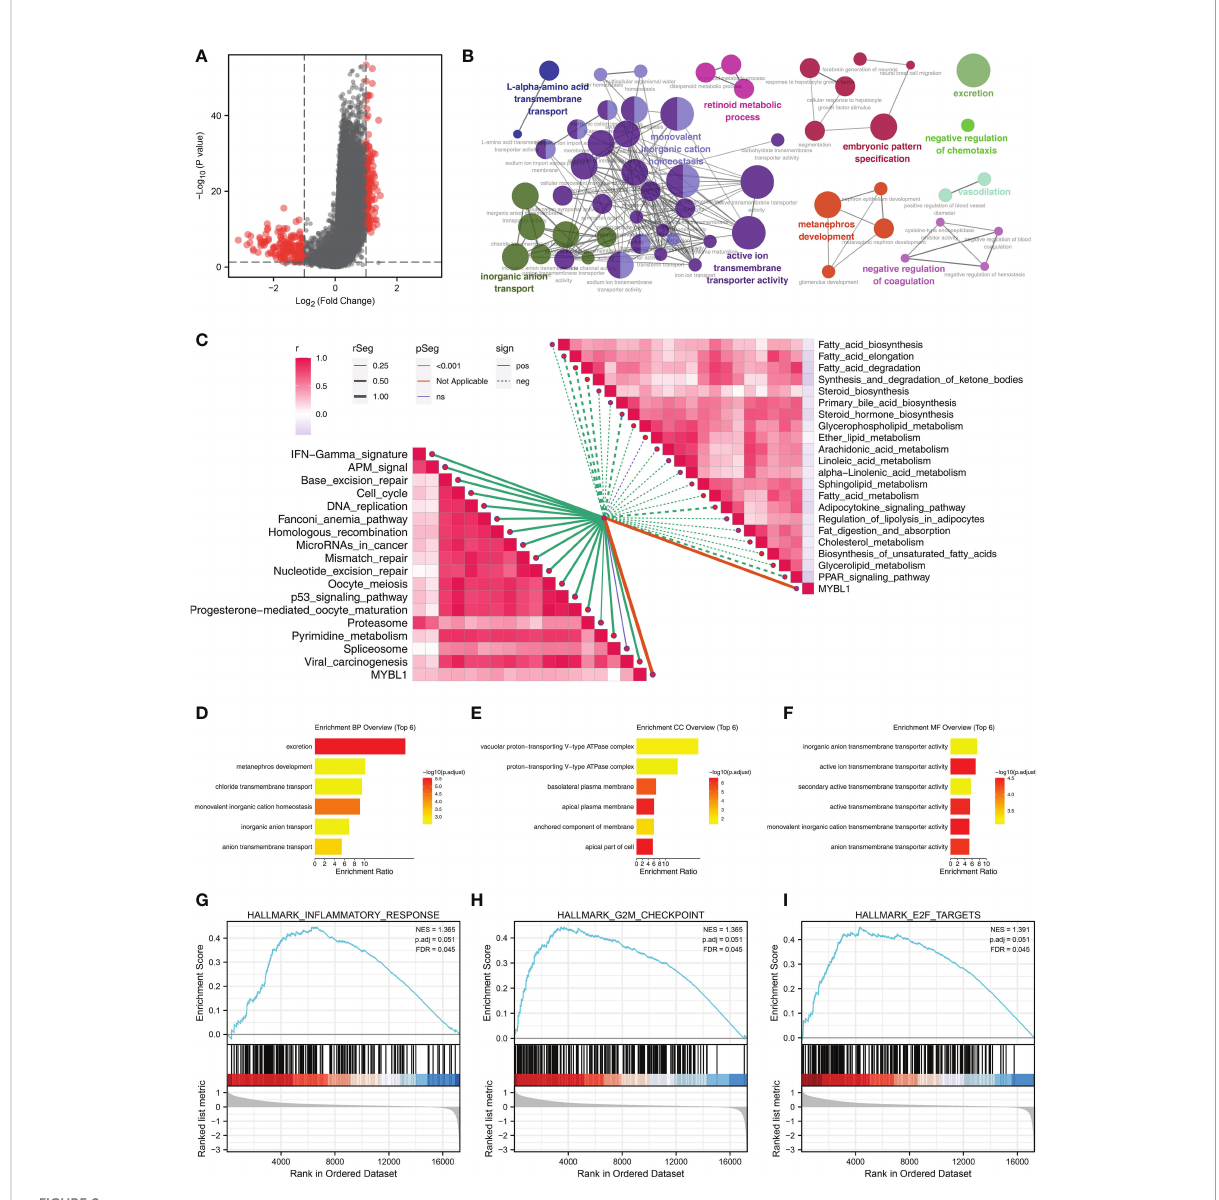
FIGURE 2 The biological role of MYBL1. (A) DEGs between the high and low MYBL1 expression; (B) clueGO analysis of DEGs; (C) Correlation of the pathways quanti fi ed by ssGSEA algorithm; (D – F) GO analysis of the DEGs; (G – I) GSEA analysis of Hallmark gene